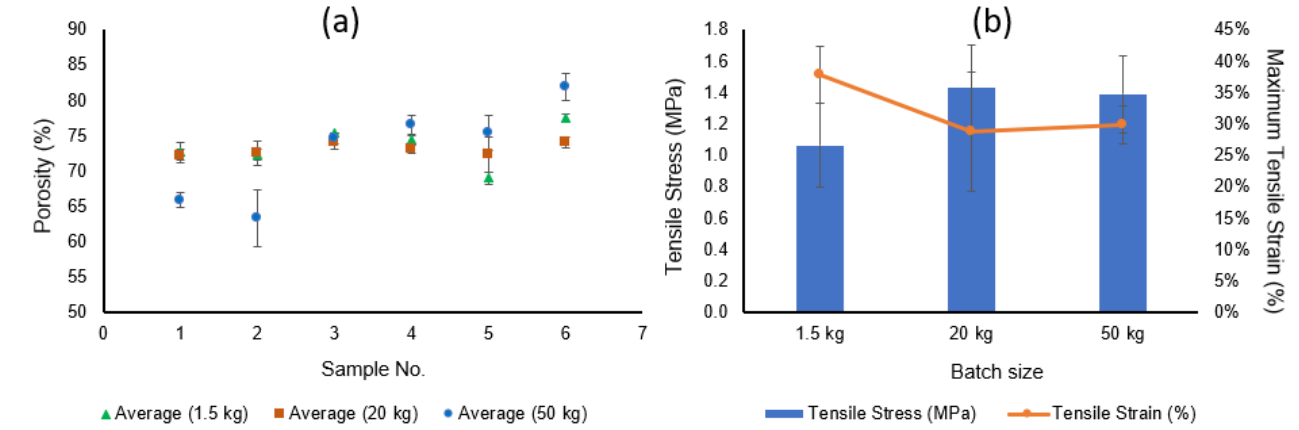
Figure 6. Comparison charts for ( a ) bulk porosity and ( b ) tensile properties of the PVDF TBHF membranes fabricated from 1.5 kg, 20 kg, and 50 kg dope batches. Table 3. Characterization and DCMD performance of membranes prepared from different batch sizes. DCMD flux and salt rejection were determined using 0.5-inch modules under out-to-in mode and a feed solution of 35 g L − 1 NaCl.